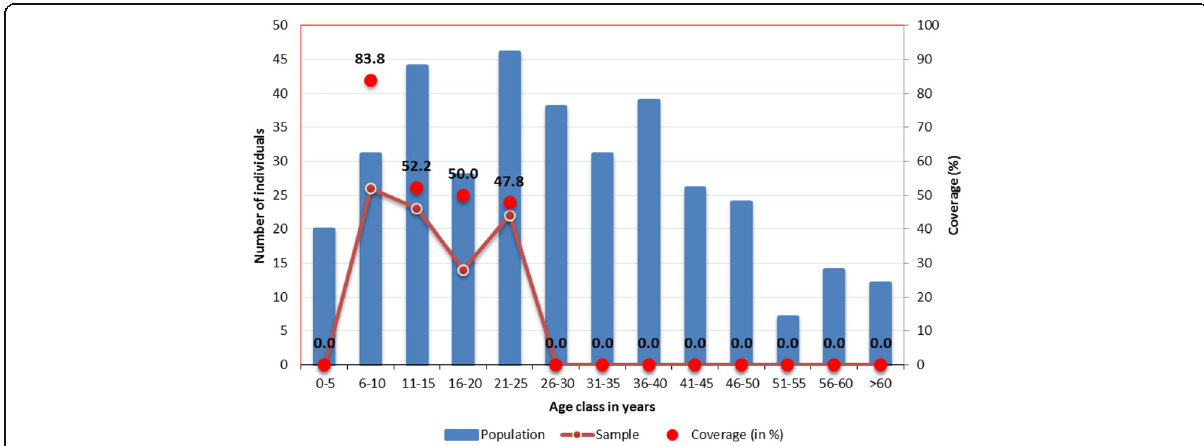
Fig. 3 Distribution of population and sample for antigen survey and coverage on different age